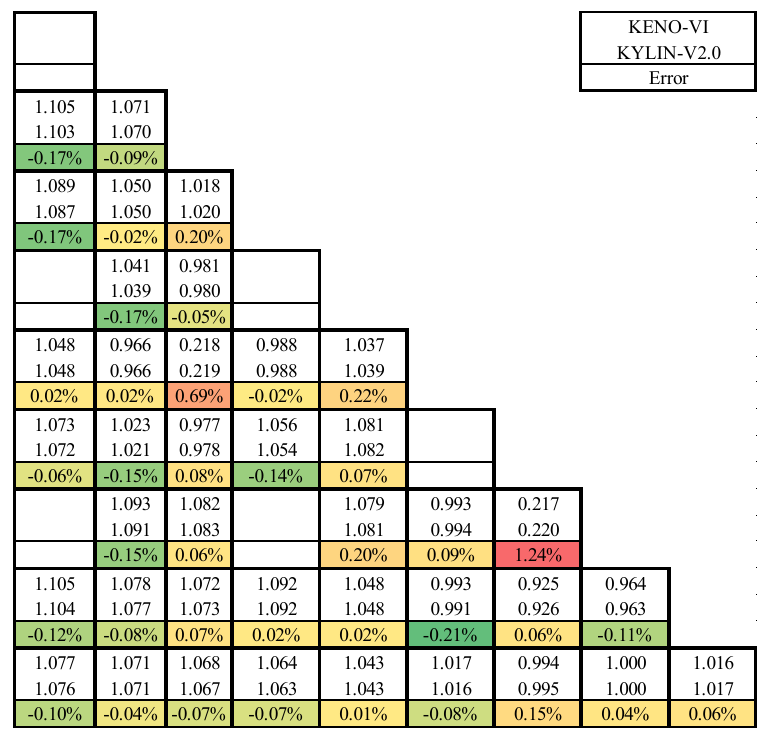
Figure 5. HZP ∆P (RMS and Max) KYLIN-V2.0 vs KENO-VI for 2D lattice simulations.